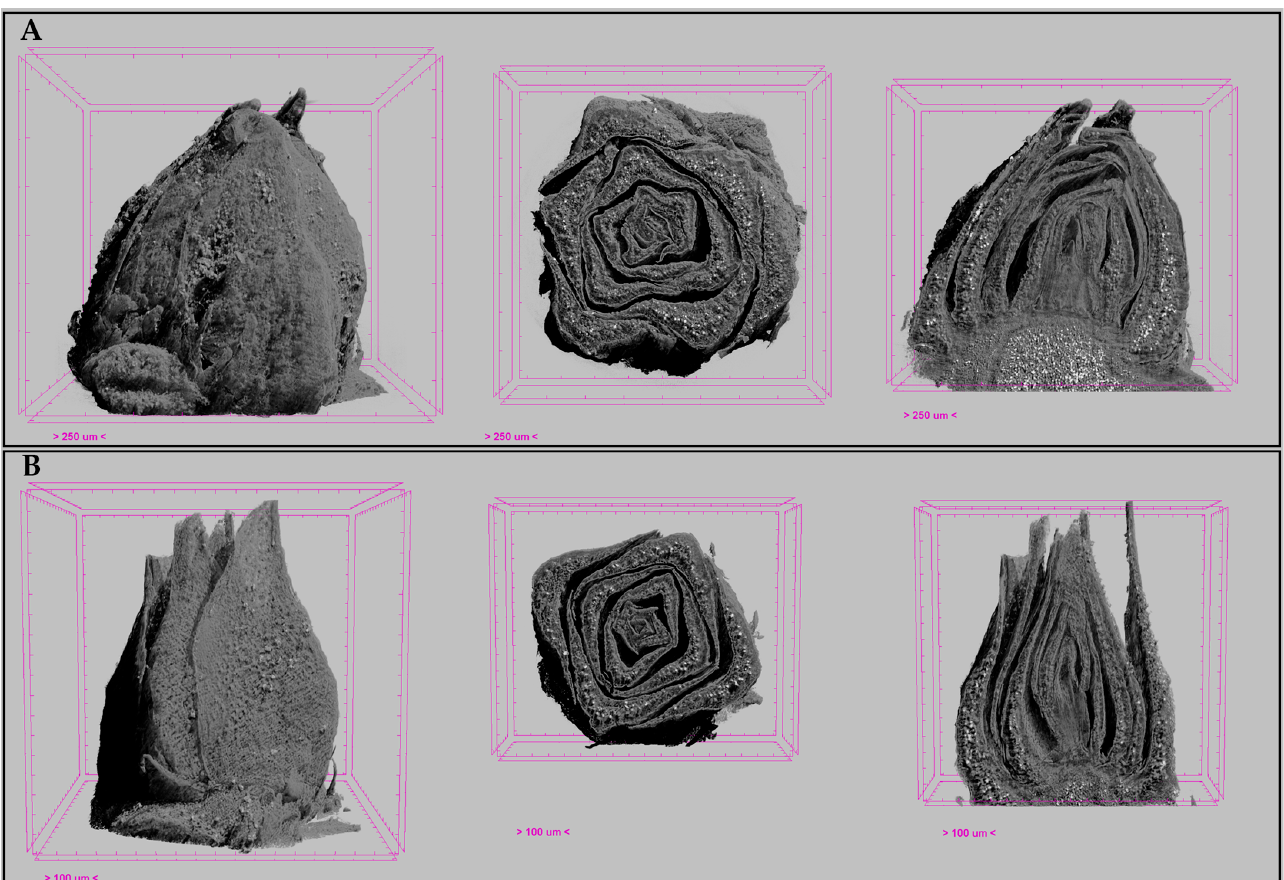
Figure 11. µ-CT 3D micrographs of “Comune S. Giorgio” bud from a spur ( A ) and “Wonderful” bud from a twig ( B ). For both buds, the full external view (left panel), the top view of the central cross section (middle panel) and a transverse section (right panel) are shown. The white brighter dots indicate the presence of higher density particles, e.g., starch grains.